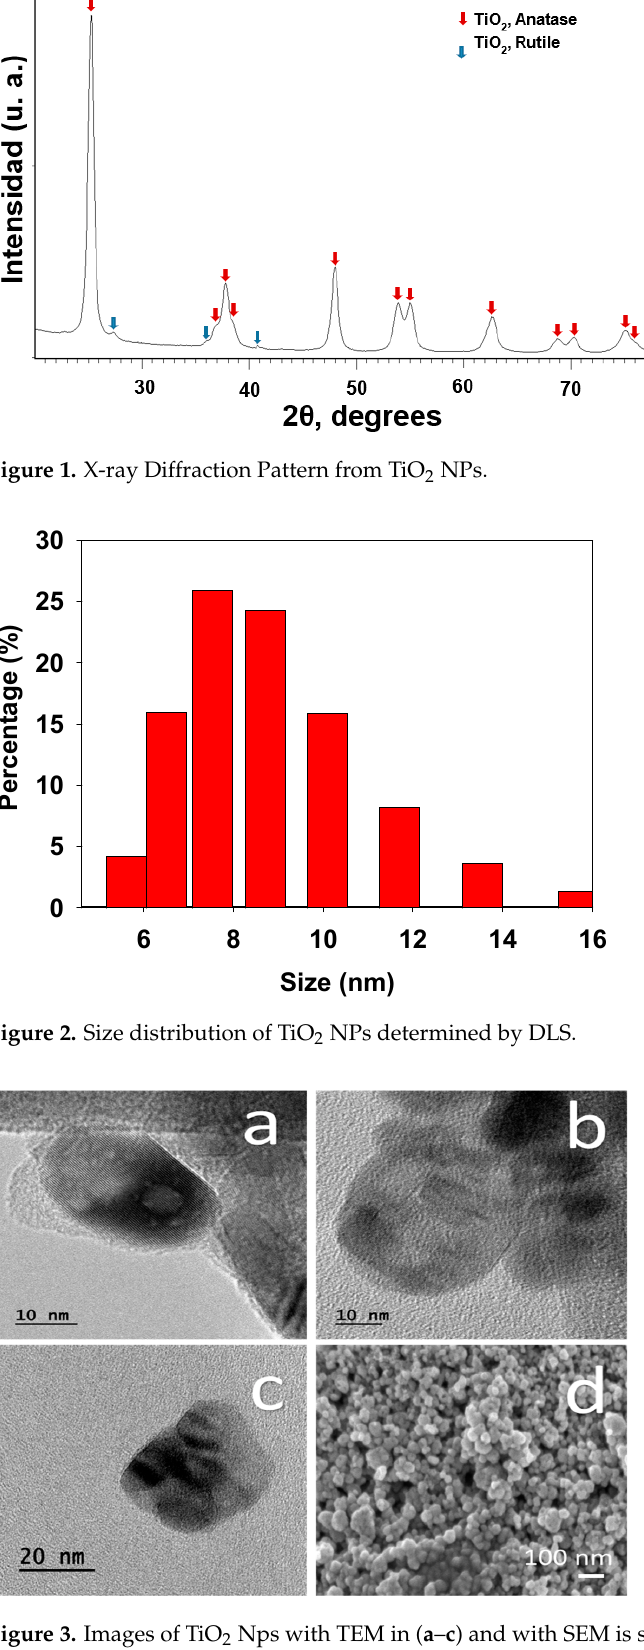
Figure 3. Images of TiO 2 Nps with TEM in ( a – c ) and with SEM is shown in ( d ). TiO 2 NPs were analyzed in WDXRF to generate a control spectrum for Ti, and then measurements in tomato root samples with and without TiO 2 NPs were incorporated into the MS medium. Figure 4 shows the WDXRF spectrum of TiO 2 NPs (black line), two peaks corresponding to Ti element at k α on 4.51 and k β at 4.95 keV were observed. With less intensity, the same peaks are observed when we incorporate the nanoparticles into the tomato growth medium (red line). The control spectrum for tomato root does not present any peaks in these energies (blue line). Figure 4. WDXRF analyses of tomato root control (blue line), and the root exposed to 20 mg/L of TiO 2 NPs (red line) and TiO 2 NPs (black line). 3.2. Changes in Tomato Root Cell Morphology after Exposure to TiO 2 NPs The changes in tomato root length were recorded. In control samples, the length was 30.14 mm, 47.84% less than the length of the tomato root that was exposed to TiO 2 NPs.